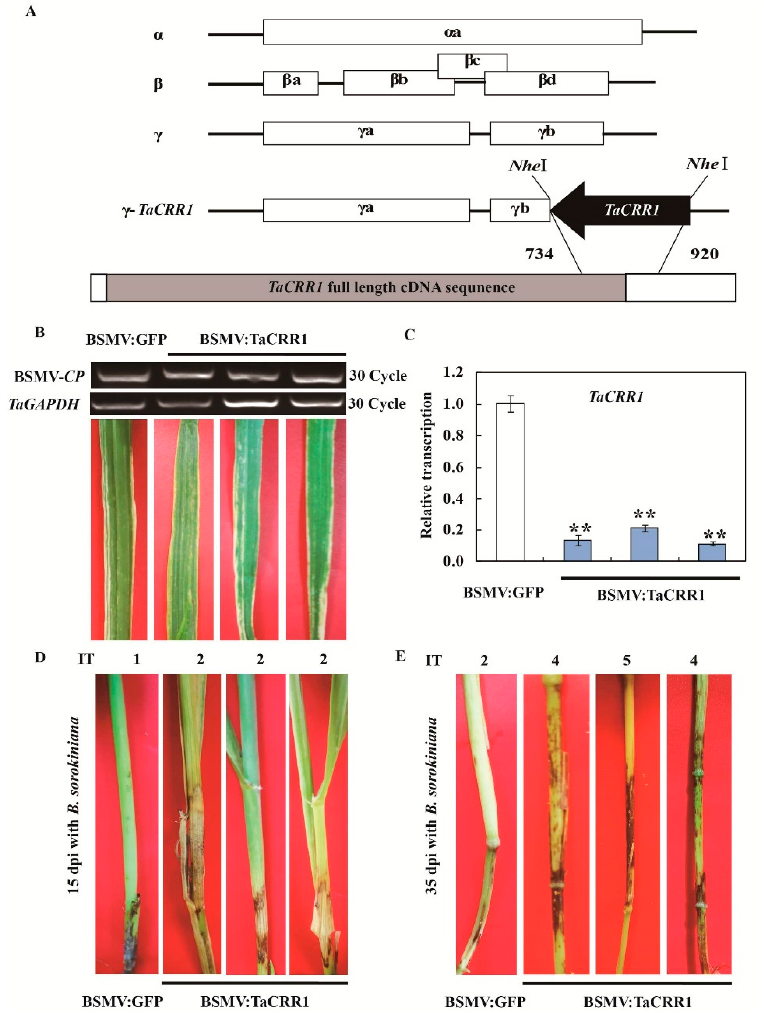
Figure 6. Silencing of TaCRR1 by barley stripe mosaic virus (BSMV)-induced gene silencing impairs resistance of the resistant wheat cv. Yangmai 6 to Bipolaris sorokiniana . ( A ) Scheme of genomic RNAs of the barley stripe mosaic virus (BSMV) and the construct BSMV: TaCRR1 of the recombinant virus expressing the wheat gene TaCRR1 . The orientation of the TaCRR1 insert is indicated by dark boxes. ( B ) RT-PCR analysis on the transcription of BSMV coat protein ( CP ) in the wheat plants infected by BSMV: GFP or BSMV: TaCRR1 for 10 days. Mild chlorotic mosaic symptoms were observed on leaves of wheat Yangmai 6 plants at 10 dpi with BSMV: GFP or BSMV: TaCRR1. ( C ) qRT-PCR analysis of the TaCRR1 gene in the wheat plants infected by BSMV: GFP or BSMV: TaCRR1 for 10 days. The relative transcript level of TaCRR1 in BSMV: TaCRR1- infected wheat Yangmai 6 plants is relative to that in BSMV: GFP-infected Yangmai 6 (control) plants (set to 1). TaGAPDH was used as an internal control. Three replicates were averaged and statistically treated ( t -test: ** p < 0.01). Bars indicate the standard error of the mean. ( D ) Common root rot symptoms on sheaths and stems of the control and TaCRR1 -silenced Yangmai 6 plants at 15 dpi with B. sorokiniana . ( E ) Common root rot symptoms on stems of the control and TaCRR1 -silenced Yangmai 6 plants at 35 dpi with B. sorokiniana